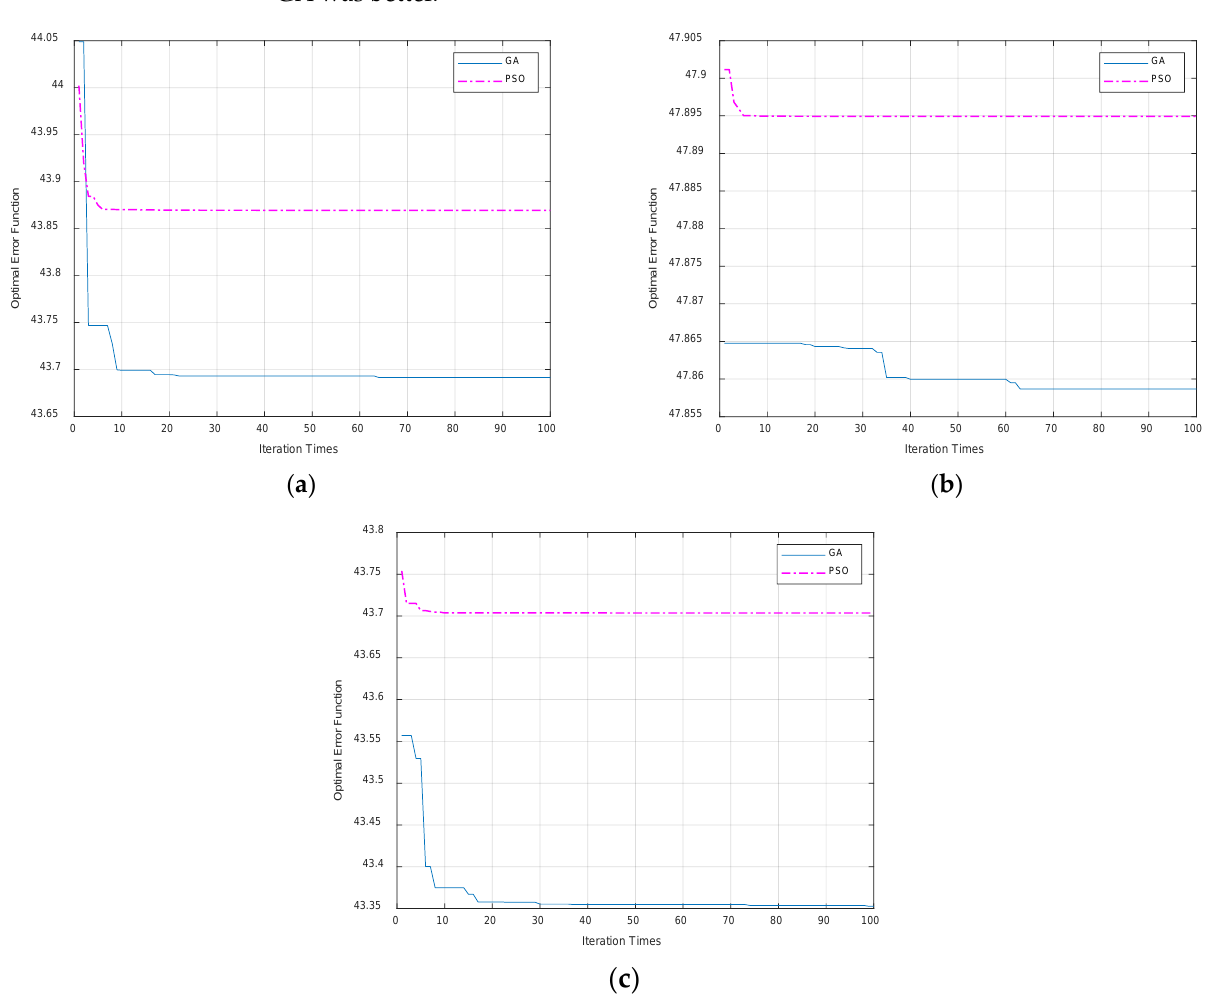
Figure 5. Optimal error function. ( a ) Mach 0.6. ( b ) Mach 0.8. ( c ) Mach 1.0. Table 4. Optimal error function results.